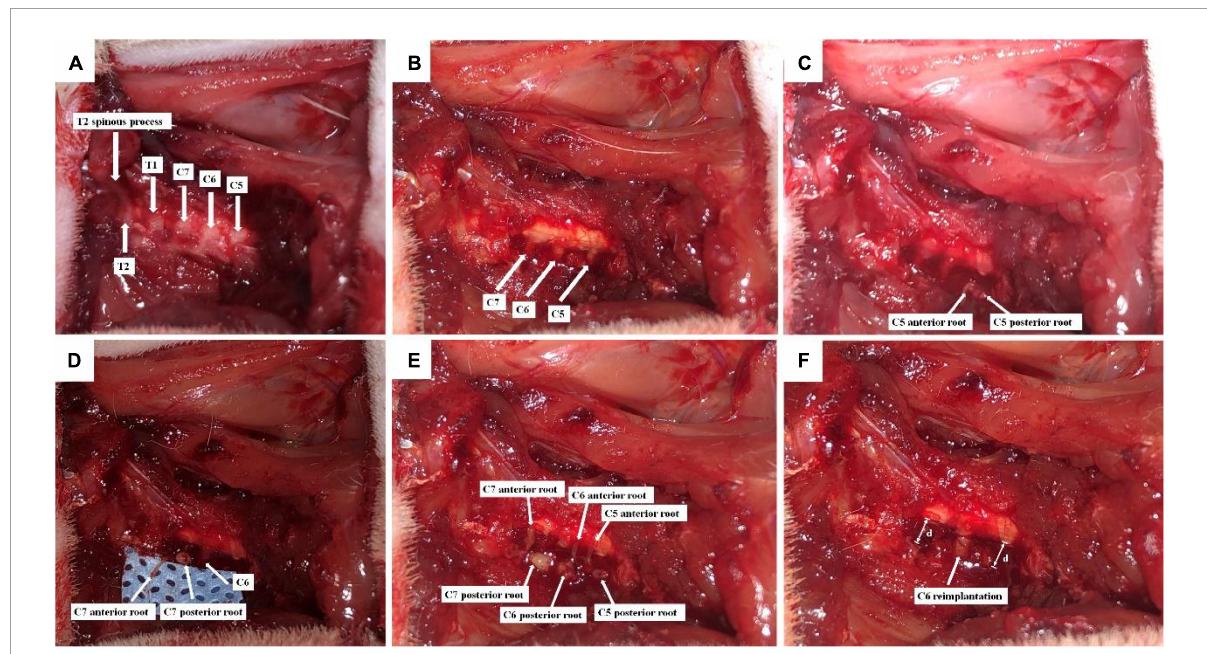
FIGURE1 Schematic diagram of C6 nerve root reimplantation after BPA. (A) C5-T2 laminae were exposed marked by T2 spinous process; (B) the right C4–C7 laminae were excised, and C5–C7 segments together with their dorsal roots were exposed; (C) C5 dorsal root was cut, and the ventral root was torn off; (D) C7 dorsal root was cut, and the ventral root was torn off; (E) C6 dorsal root was cut, and the ventral root was torn off. C5–C7 were placed on the surface of the spinal cord; (F) 5–7 mm (d) nerve tissues were excised from the dorsal and ventral roots of C5 and C7, so that distal nerve roots were retracted. Then, C6 dorsal and ventral roots were